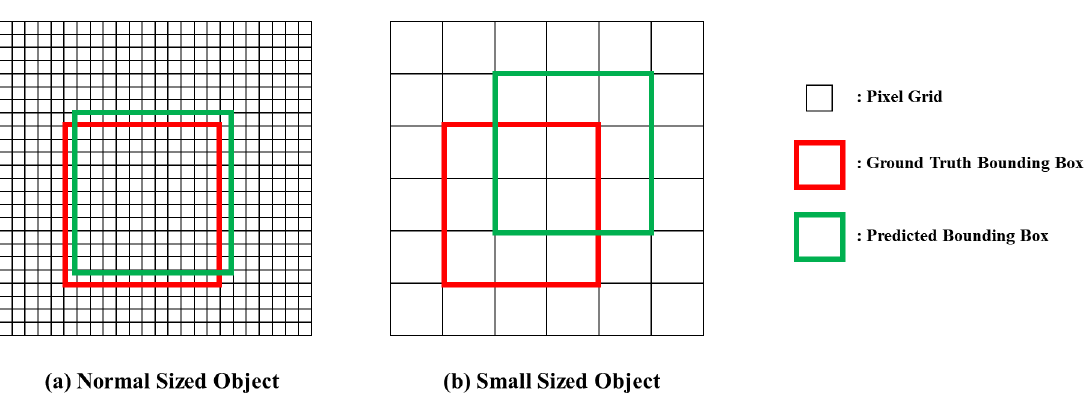
Figure 2. The sensitivity difference of IoU on normal-sized objects and small-sized objects. As the location of bounding boxes can only change discretely, the sensitivity of IoU is much lower in small-sized